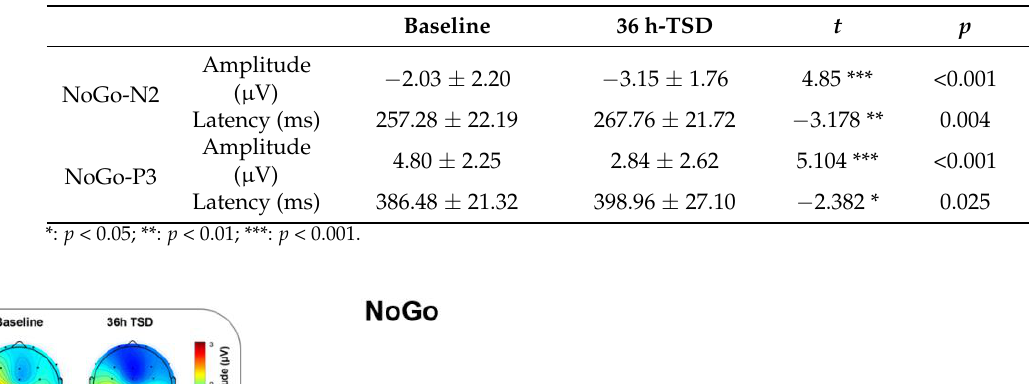
Table 2. Amplitude and latency (mean ± standard deviation) of NoGo-N2 and NoGo-P3 at baseline and 36-h total sleep deprivation (TSD) and t -test results.